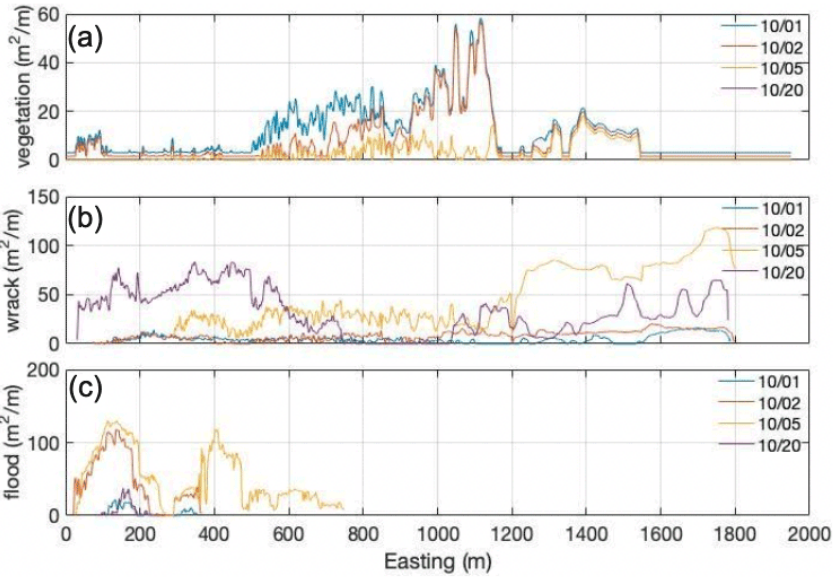
Figure 7. (a) Wrack, (b) beach berm vegetation, and (c) flood distribution areas along the Sisal beach for 1, 2, 5, and 20 October 2020.